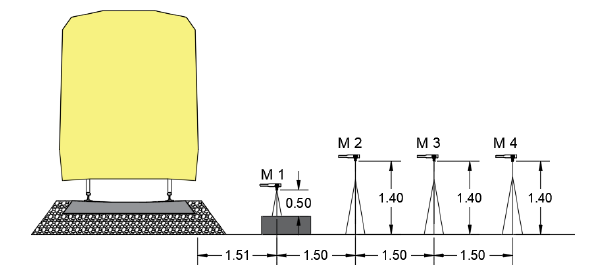
Figure 3. Experimental setup